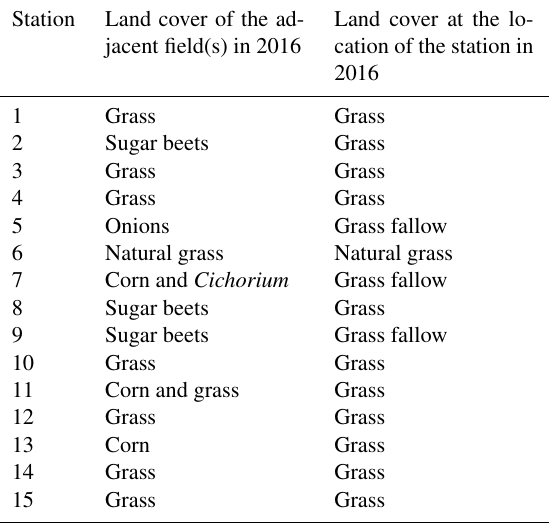
Table 3. Land cover of adjacent fields and at the locations of the soil moisture monitoring stations.